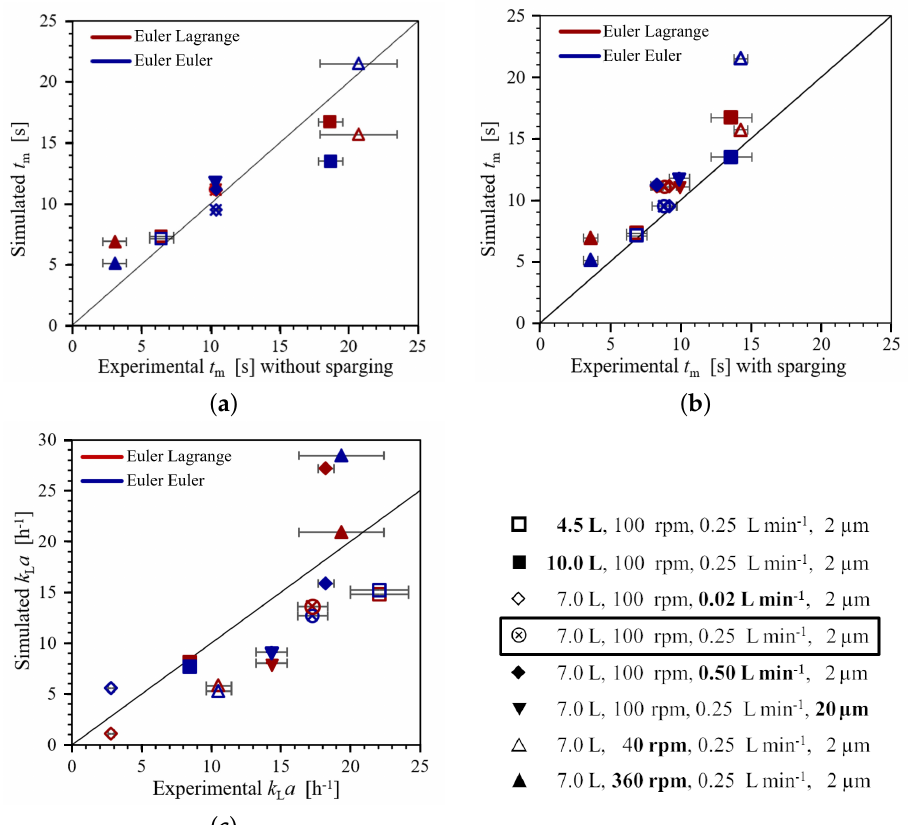
Figure 10. Experimental and simulation results of mixing times without and with sparging and for the volumetric oxygen mass transfer coefficient. ( a ) Experiments without sparging; ( b ) experiments with sparging; ( c ) volumentric oxygen mass transfer